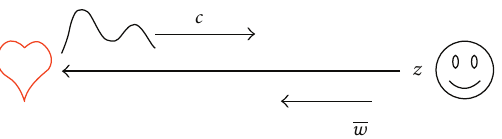
Figure 1: Schematic representation of the heart-head axis. A pressure wave propagating from the heart toward the head with velocity 𝑐 is represented together with the direction of the internal jugular vein blood velocity 𝑤 that propagates from the head toward the